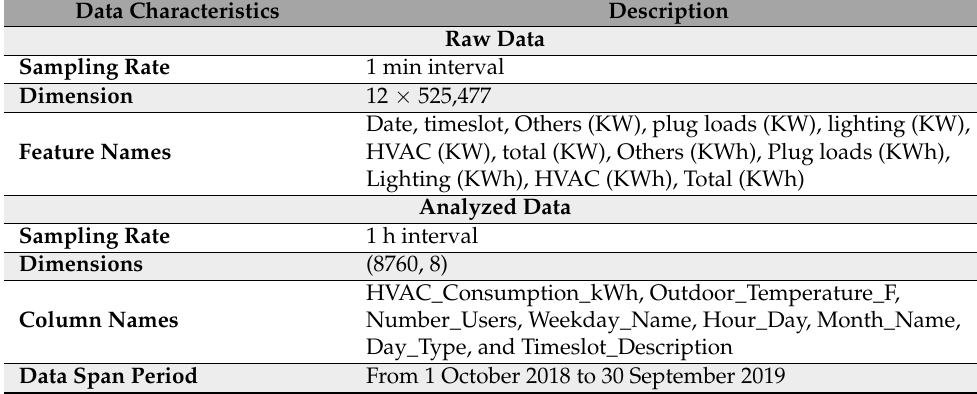
Table 1. HARC data—a